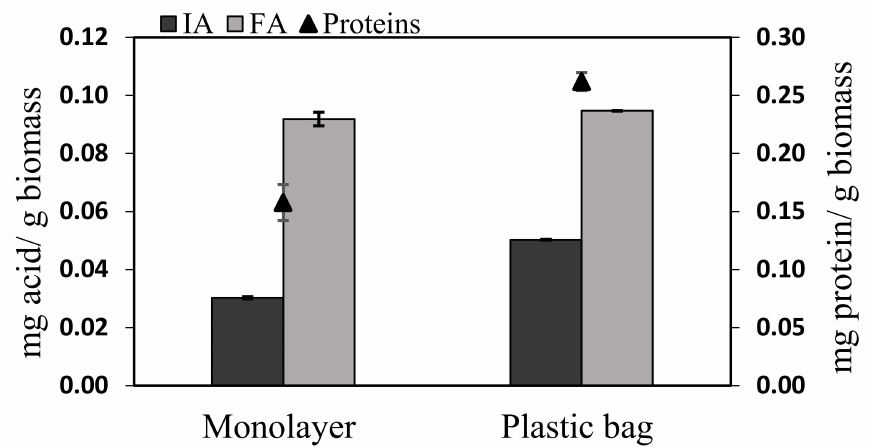
Figure 6. SSF in larger scale fermenters of A. oryzae from corn cobs: Organic acid productions and protein secretion